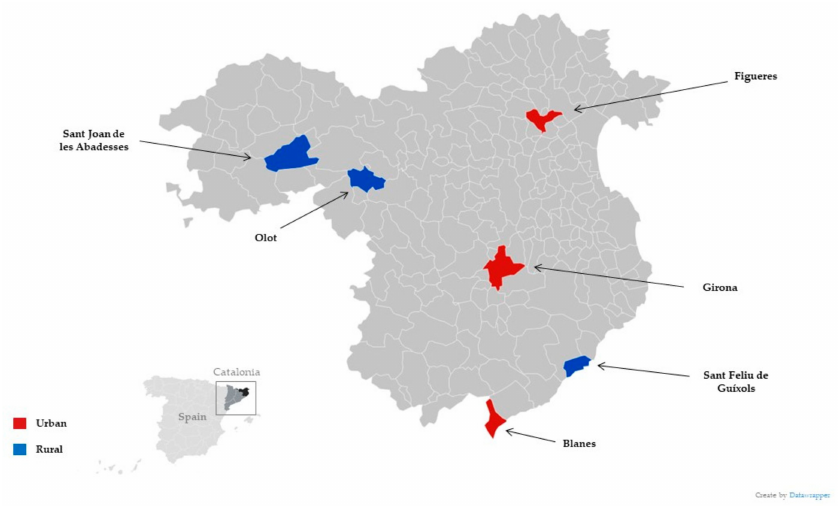
Figure A1. Health Region of Girona in Catalonia (Spain), with the municipalities of the study area.